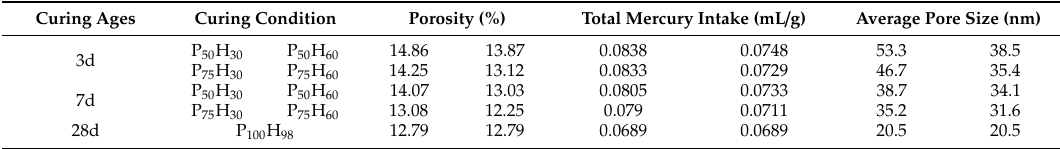
Table 8. E ff ect of di ff erent humidity (H) on the pore structure of concrete under di ff erent